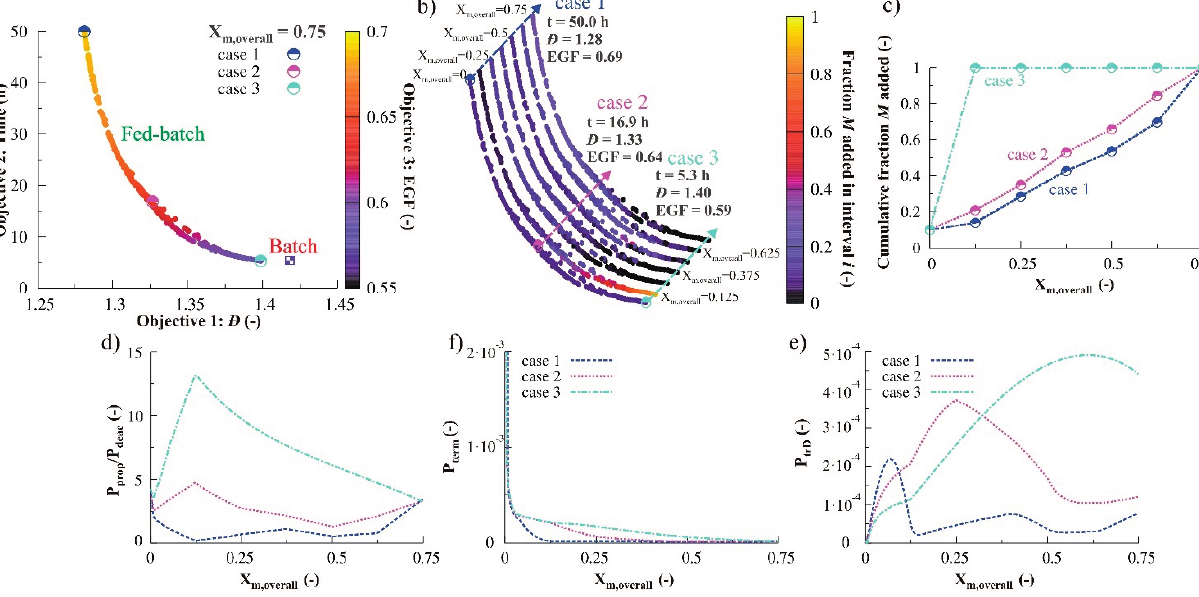
Figure 8. Results for the multi-objective optimization (MOO) of NMP of styrene (120 °C) using a fed-batch monomer program (constant molar flow rate per Δ X m ,overall of 0.125 until X m, overall = 0.75; [ M ] 0 /[ R 0 X ] 0 = 1000/1). ( a ) Pareto-optimal front and corresponding isothermal front; ( b ) Variation of the seven variables (fraction monomer added initially (variable 1) and during a conversion interval (variable 2–7) along the Pareto-optimal front; ( c ) Cumulative fraction of monomer added as a function of X m, overall for three selected cases; ( d ) Ratio of probability for propagation to deactivation as a function of X m ,overall for the selected cases; ( e ) Probability for termination as a function of X m ,overall for the selected cases; ( f ) Probability for chain transfer to dimer as a function of X m ,overall for the selected